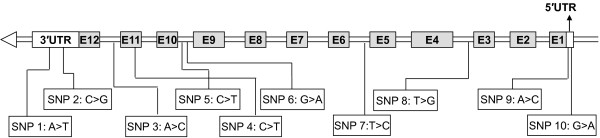
Location of 10 identified SNPs in UGDH.